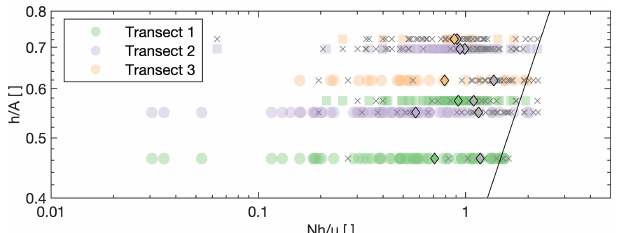
Table 3. Comparison of wind characteristics during the period of 16:30–16:40UTC on 5 May 2017 measured by the sonic anemome- ters at 100m height on the upwind SW and downwind NE ridges. − 1 , where U is the Turbulence intensity is defined as I = σ U U